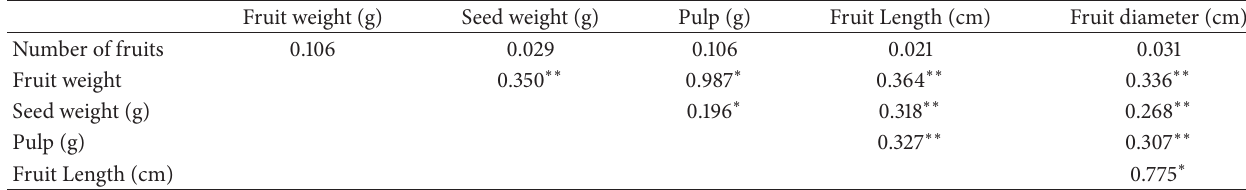
Table 4: Relationship between fruit traits in Sclerocarya birrea in